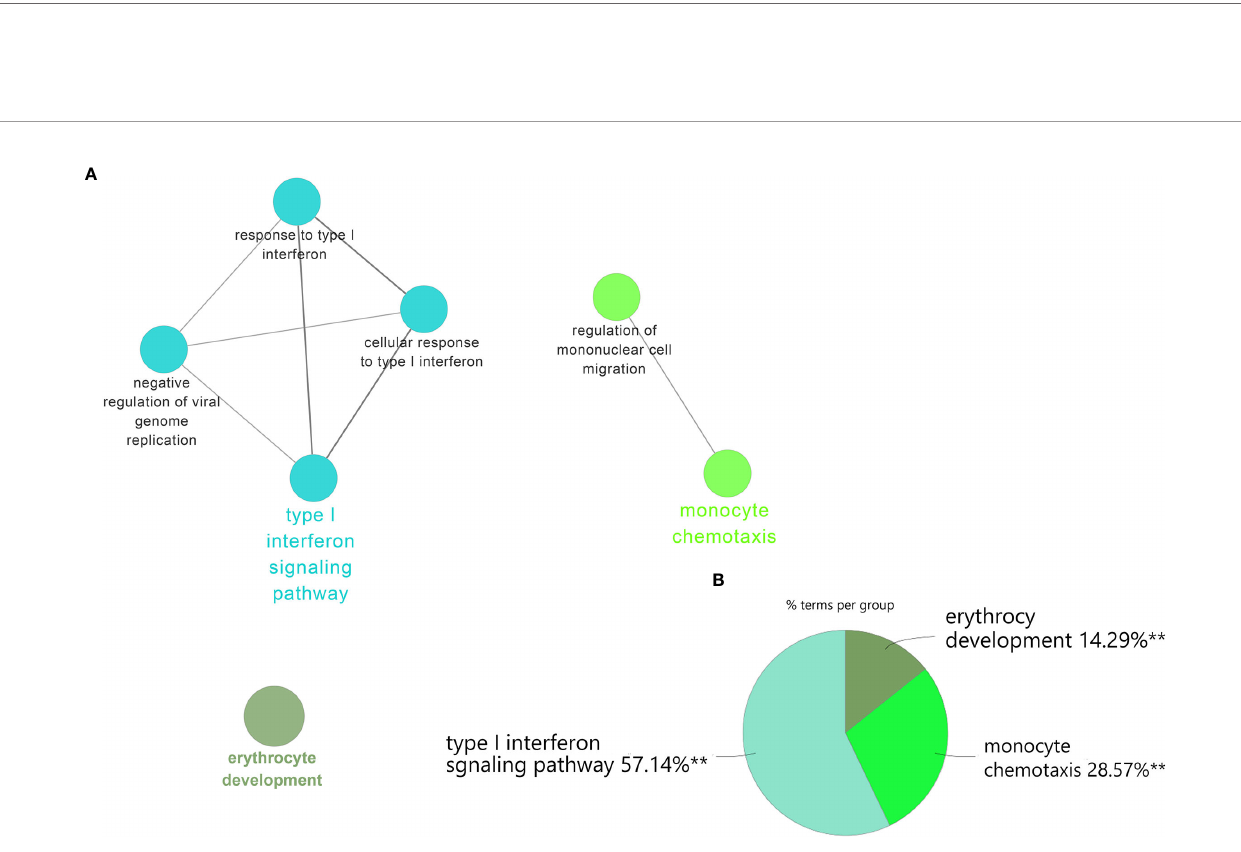
FIGURE 6 | ClueGO enrichment analysis. (A) The interaction network of GO terms generated by the Cytoscape plug-in ClueGO. The signi fi cant term of each group is highlighted. (B) Proportion of each GO terms group in the total. GO, gene ontology. ** p <